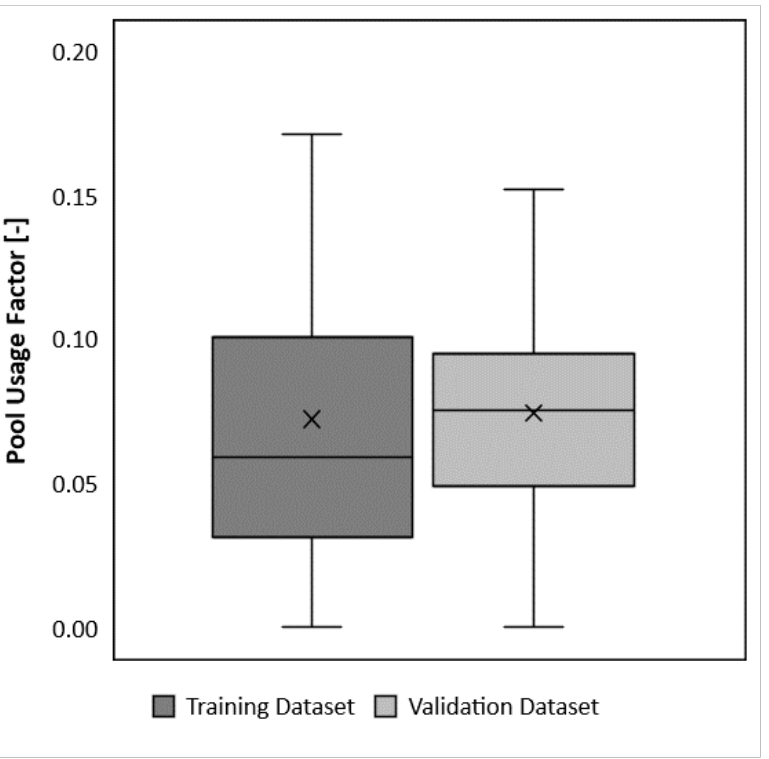
Figure 15. The dispersion of the independent variables in the prediction model, for each dataset used in the analysis.